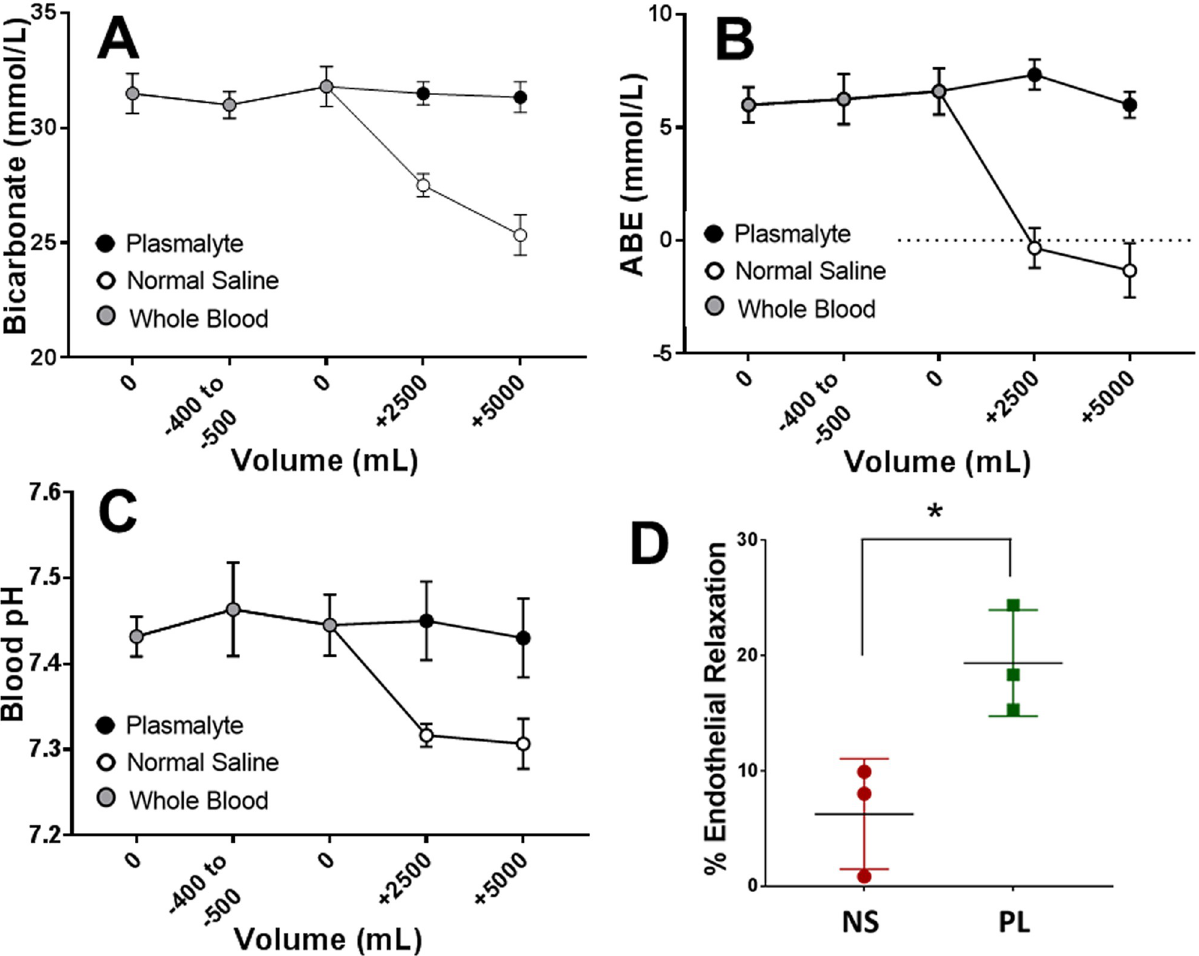
Fig 6. Resuscitation with Normal Saline but not Plasma-Lyte leads to acidosis and endothelial dysfunction in a porcine model. A drop in bicarbonate ( A , � p < 0.05, n = 3 pigs in each group) arterial base excess (ABE) ( B � p < 0.05, n = 3 pigs in each group) occurred with 2500 mL and 5000 mL, and a drop in pH occurred with 5000 mL ( C , � p < 0.05, n = 3 pigs each group) of NS administration. No significant changes occurred during whole blood removal, whole blood return, or PL administration. PSV were atraumatically harvested following resuscitation with NS or PL and suspended in a muscle bath then pre-contracted with phenylephrine (5 x 10 − 7 M) and treated with carbachol ( D , 5 x 10 − 7 M, n = 3 pigs in each group, � p < 0.05, unpaired